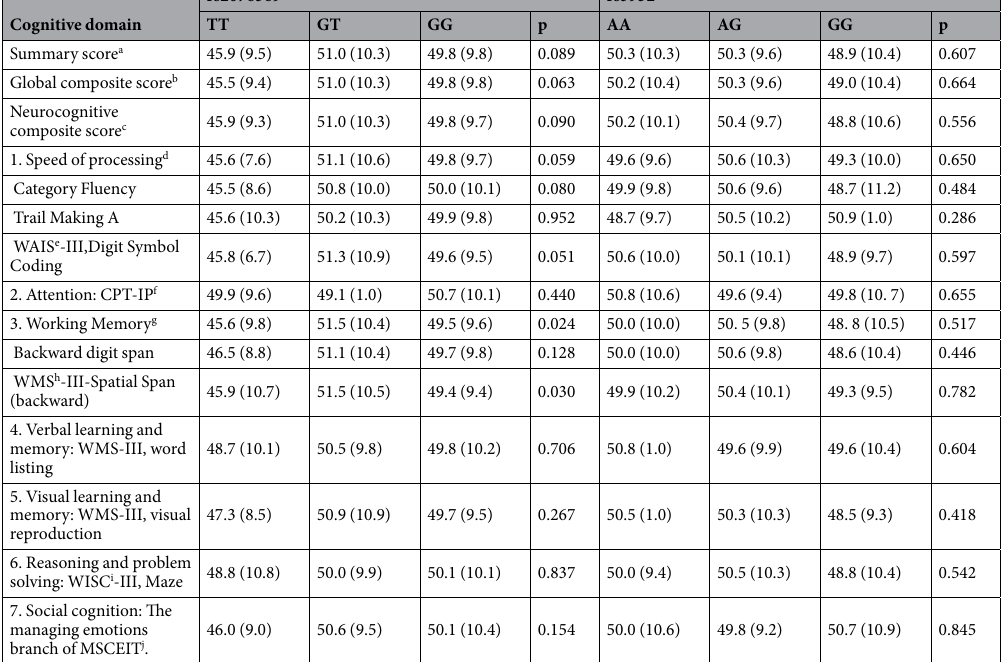
Table 4. The association between genotypes of PICK1 and cognitive function in schizophrenic patients. All data were standardized to T scores and presented by mean (standard deviation). According to normality of data, ANOVA was used for all scales. If the result was significant, the post-hoc analysis with Bonferroni test was applied to examine the between-genotype differences (data was shown in the results section). a Summary score: principal component analysis with varimax rotation showed the 7 domains of cognitive tests can be reduced to one dimension and we calculated the estimated summary score. b Global composite score : an overall composite T scores that included all 7 domains was calculated by standardizing the sum of T scores. c Neurocognitive composite score : an overall composite T scores that included all 6 neurocognitive domains, excluding social cognition, was calculated by standardizing the sum of T scores. d Speed of processing : an overall composite T scores that included all 3 domains (Category fluency, Trail making A, WAIS-III Digit Symbol- coding) was calculated by standardizing the sum of T scores. e WAIS-III : Wechsler adult intelligence scale-Third Edition. f CPT-IP : Continuous Performance Test-Identical Pairs (only showed CPT1- d ′ value: the d ′ value in the first session of CPT). g Working memory : an overall composite T scores that included all 2 domains (Backward digit span, WMS-III, Spatial span) was calculated by standardizing the sum of T scores. h WMS-III : Wechsler memory scale-Third Edition. I WISC-III : Wechsler intelligence scale for children-Third Edition. j MSCEIT: Mayer-Salovey-Caruso Emotional Intelligence